Question: Name the type of graph shown.
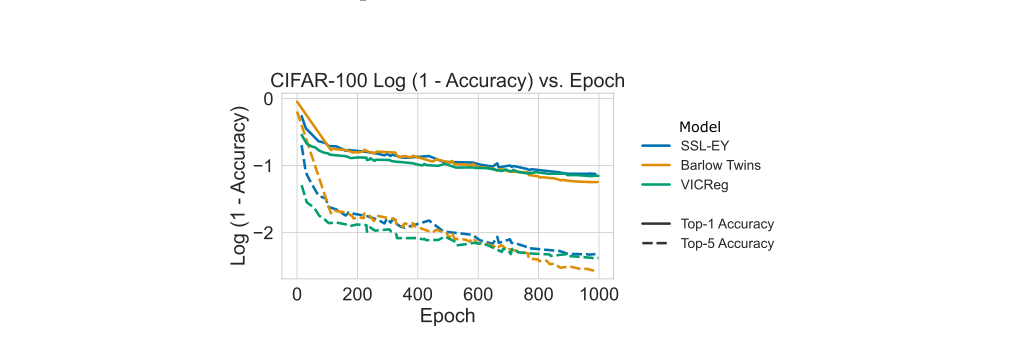
Answer: line